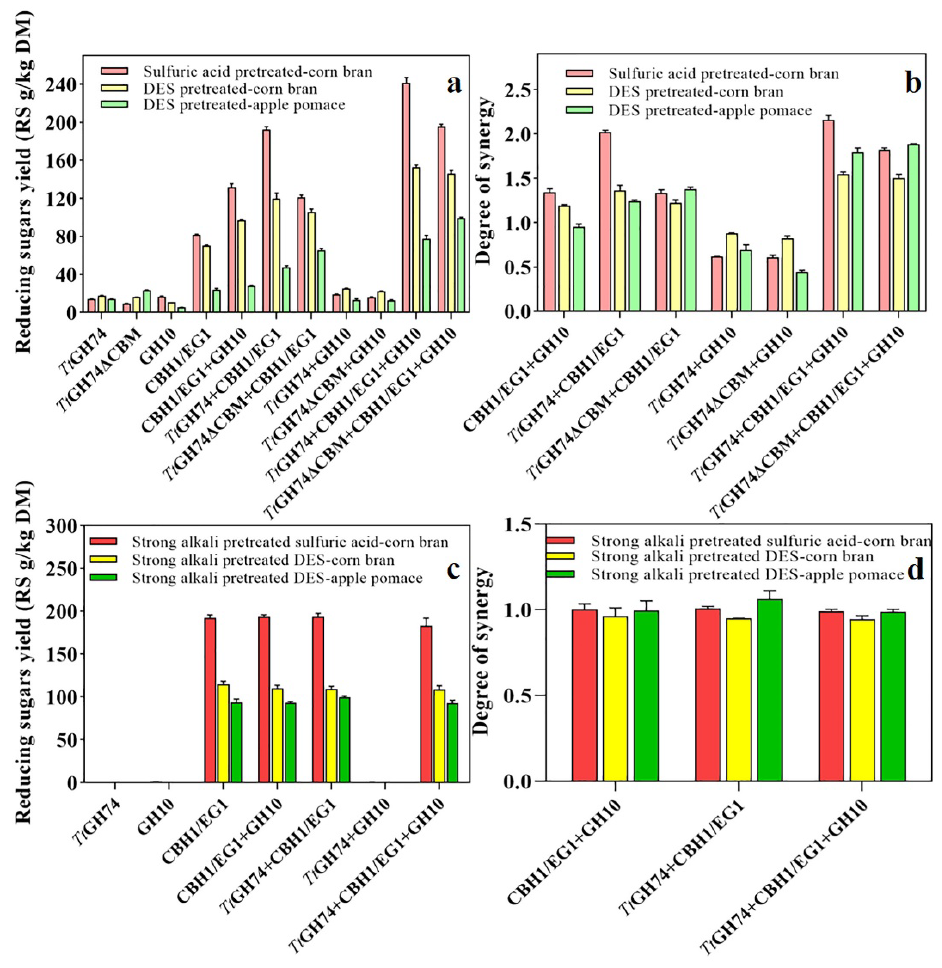
Figure 9. The synergy between Tt GH74, Tt GH74 ∆ CBM, GH10 xylanase and the CBH1/EG1 mixture on sulfuric-acid-pretreated corn bran and DES-pretreated lignocellulose ( a , b ). Enzymatic hydrolysis verification of pretreated lignocellulose components treated by strong alkali ( c , d ). The product yield was expressed in grams of reducing sugar produced by per kilogram of dry material (Reducing Sugars g/kg Dry Material, RS g/kg DM).